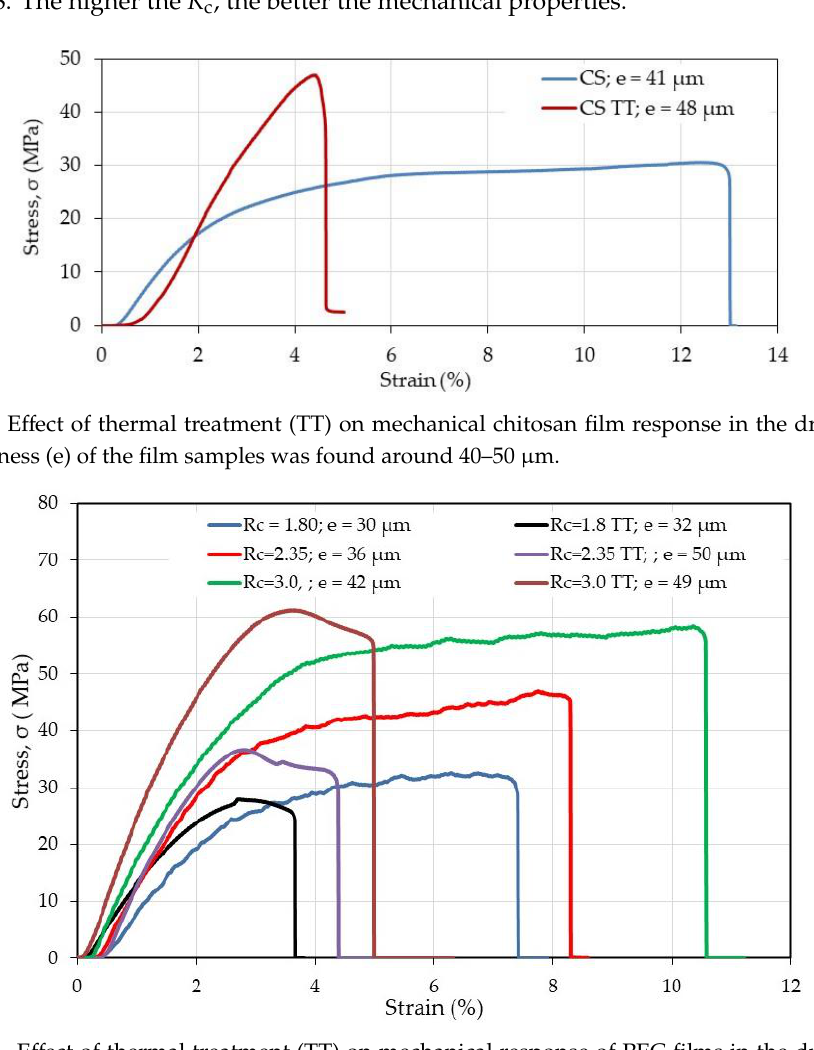
Figure 10. Effect of thermal treatment (TT) on mechanical response of PEC films in the dried state. Stress as a function of strain (%) before and after thermal treatment for different complexes characterized by R c .